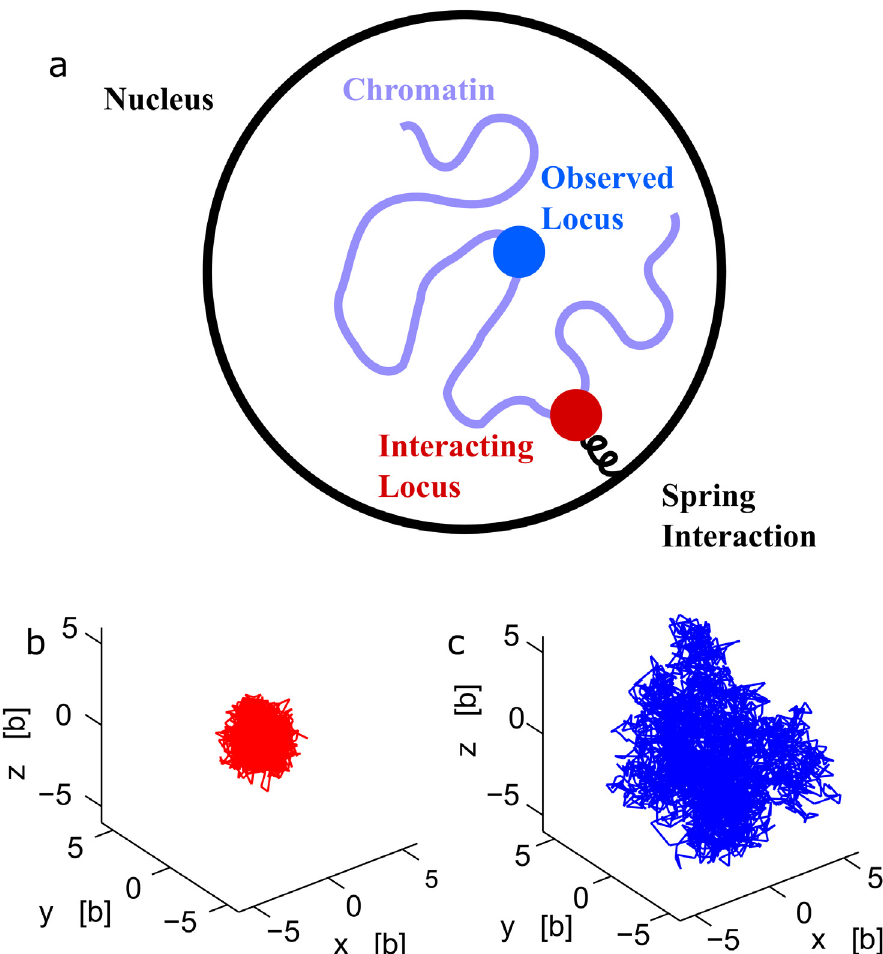
Fig 1. A polymer interacting with multiple potential wells. (a) Schematic representation of a polymer, where some monomers (red) interact with fixed harmonic potential wells, while monomer c (blue) is observed. (b-c) Stochastic trajectories of three monomers, part of a polymer, where the two extremities interact with two potential wells fixed at the origin and at position μ = (5 b , 0, 0) respectively. The middle monomer trajectory (blue) is more extended than the two others, as shown for a polymer of length N = 21 (b) and N = 41